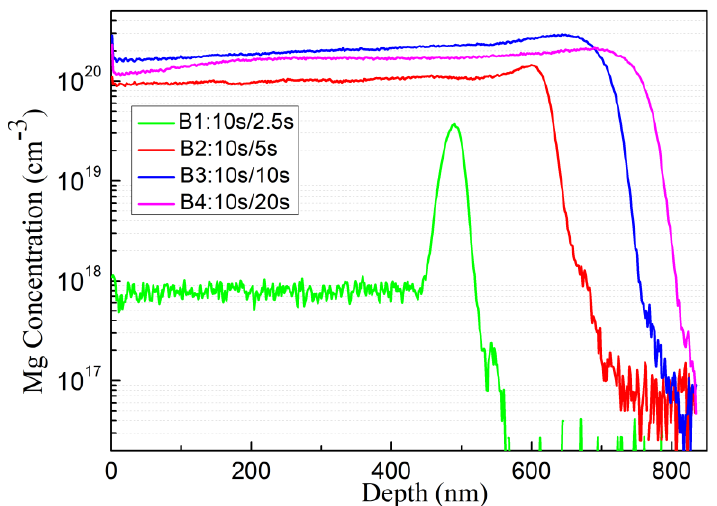
Figure 5. SIMS profile, Mg doping concentrations of sample B1, B2, B3 and B4.